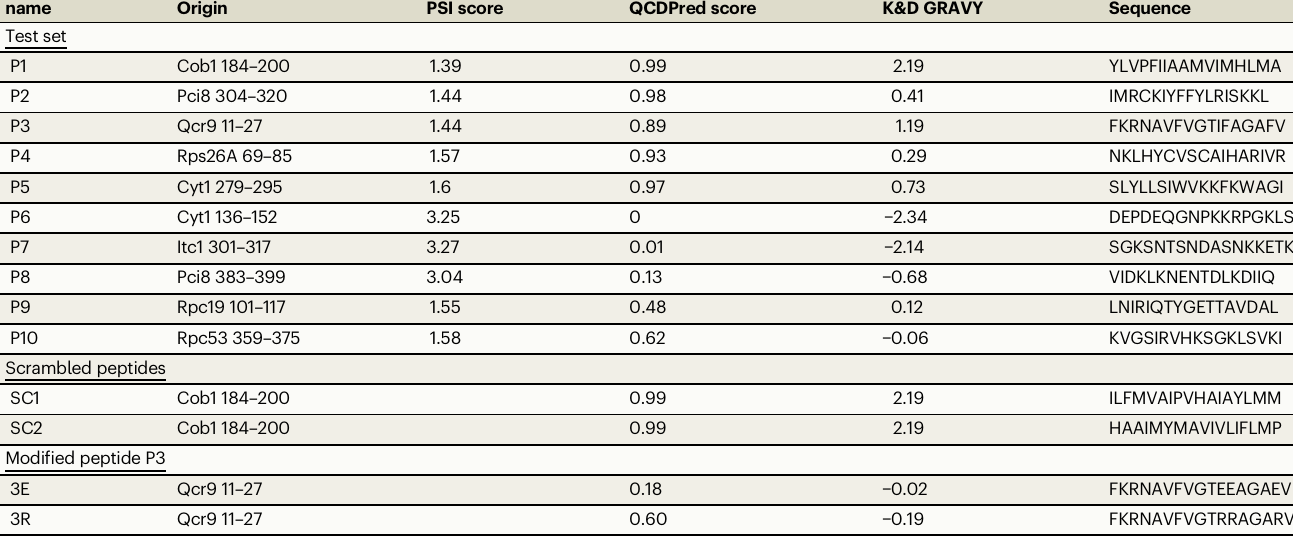
Table 1 | List of selected peptides, their origin, sequence, PSI, and GRAVY